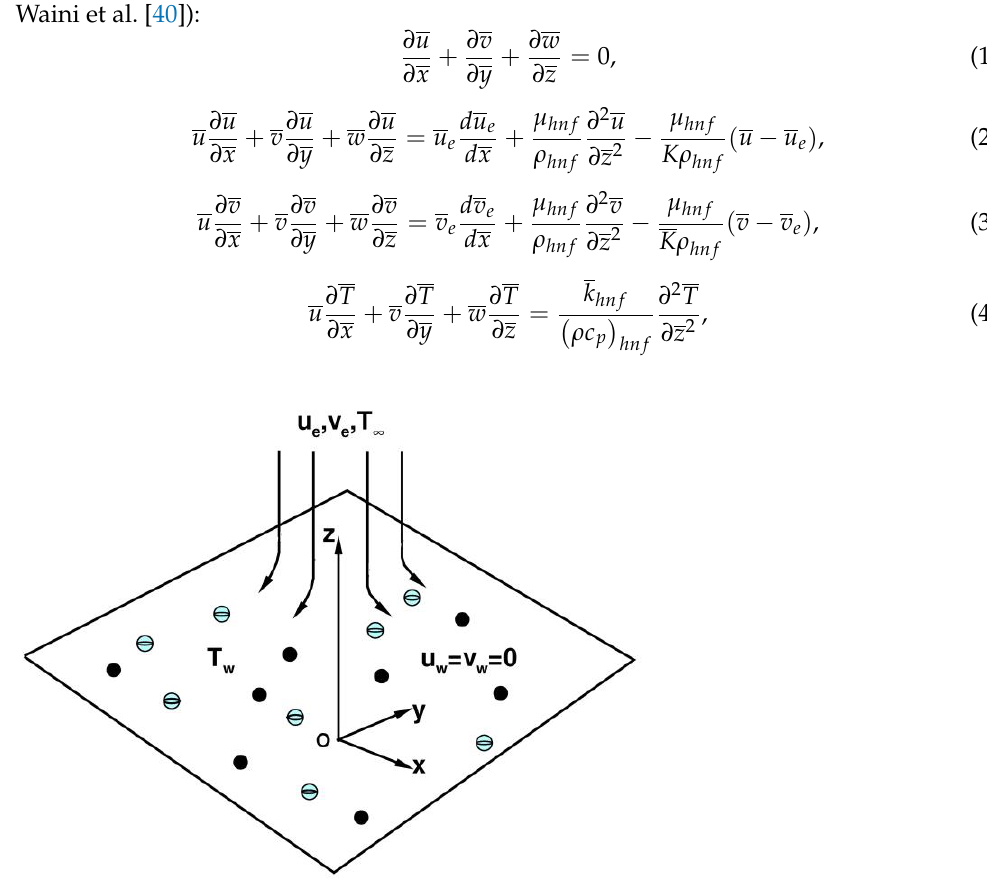
Figure 1. Physical model and coordinate systems.